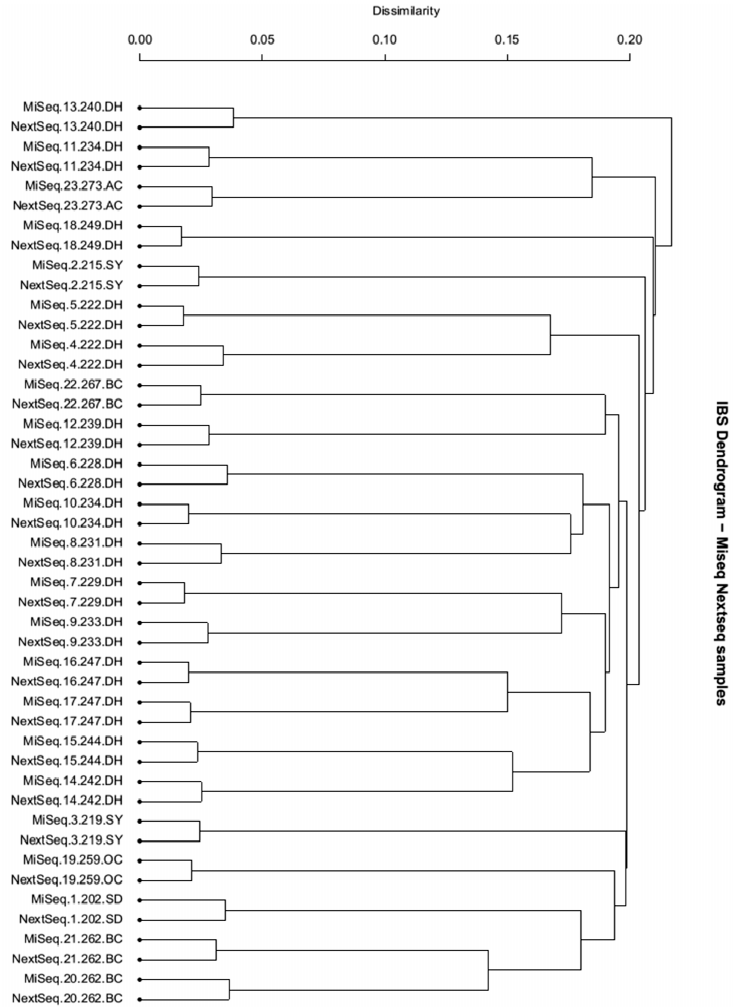
Figure 6. Dendrogram for the combined MiSeq and NextSeq dataset of 23 E. dunnii samples with a MAF of 0.05 and missing data below 20%. Each of 23 individuals has two sets of ddRADseq SNPs data: one set sequenced on a MiSeq and another sequenced on a NextSeq 500.